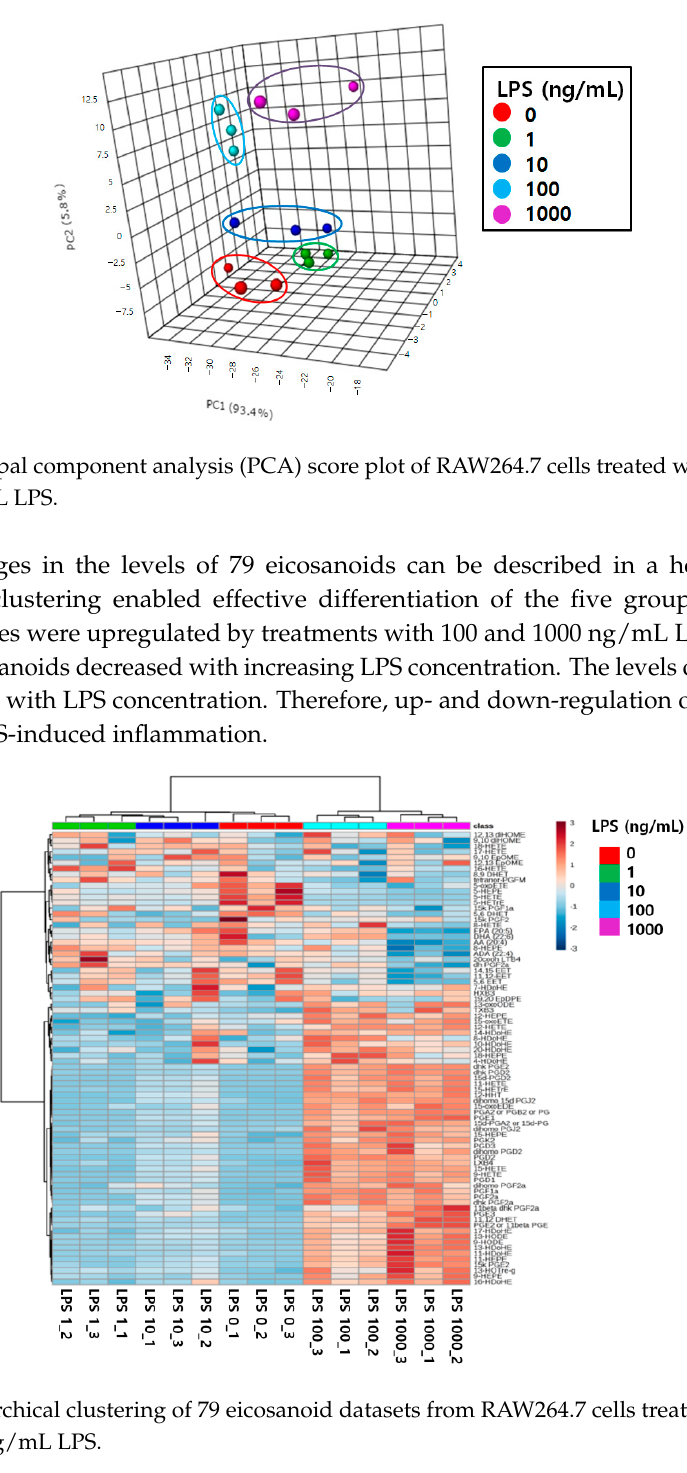
Figure 6. Hierarchical clustering of 79 eicosanoid datasets from RAW264.7 cells treated with 0, 1, 10, 100, and 1000 ng/mL LPS.